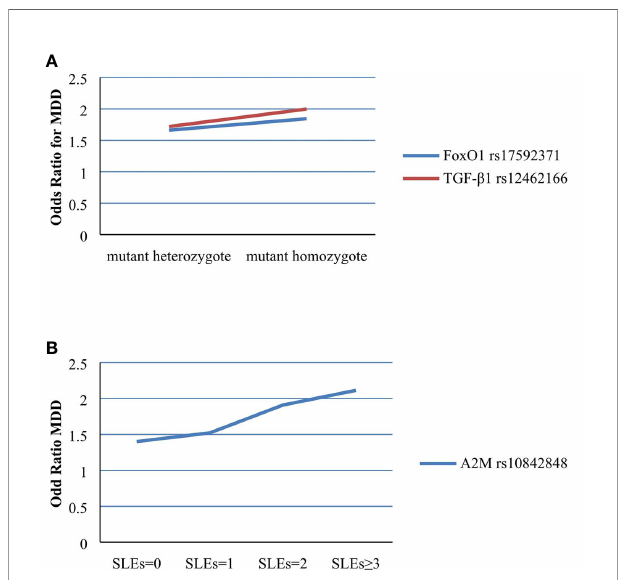
FIGURE 2 | (A) Effect of SLEs on MDD in different genotypes of rs17592371 in FoxO1 and rs12462166 in TGF- b 1. (B) Effect of rs10842848 in A2M on MDD in different number of SLEs.